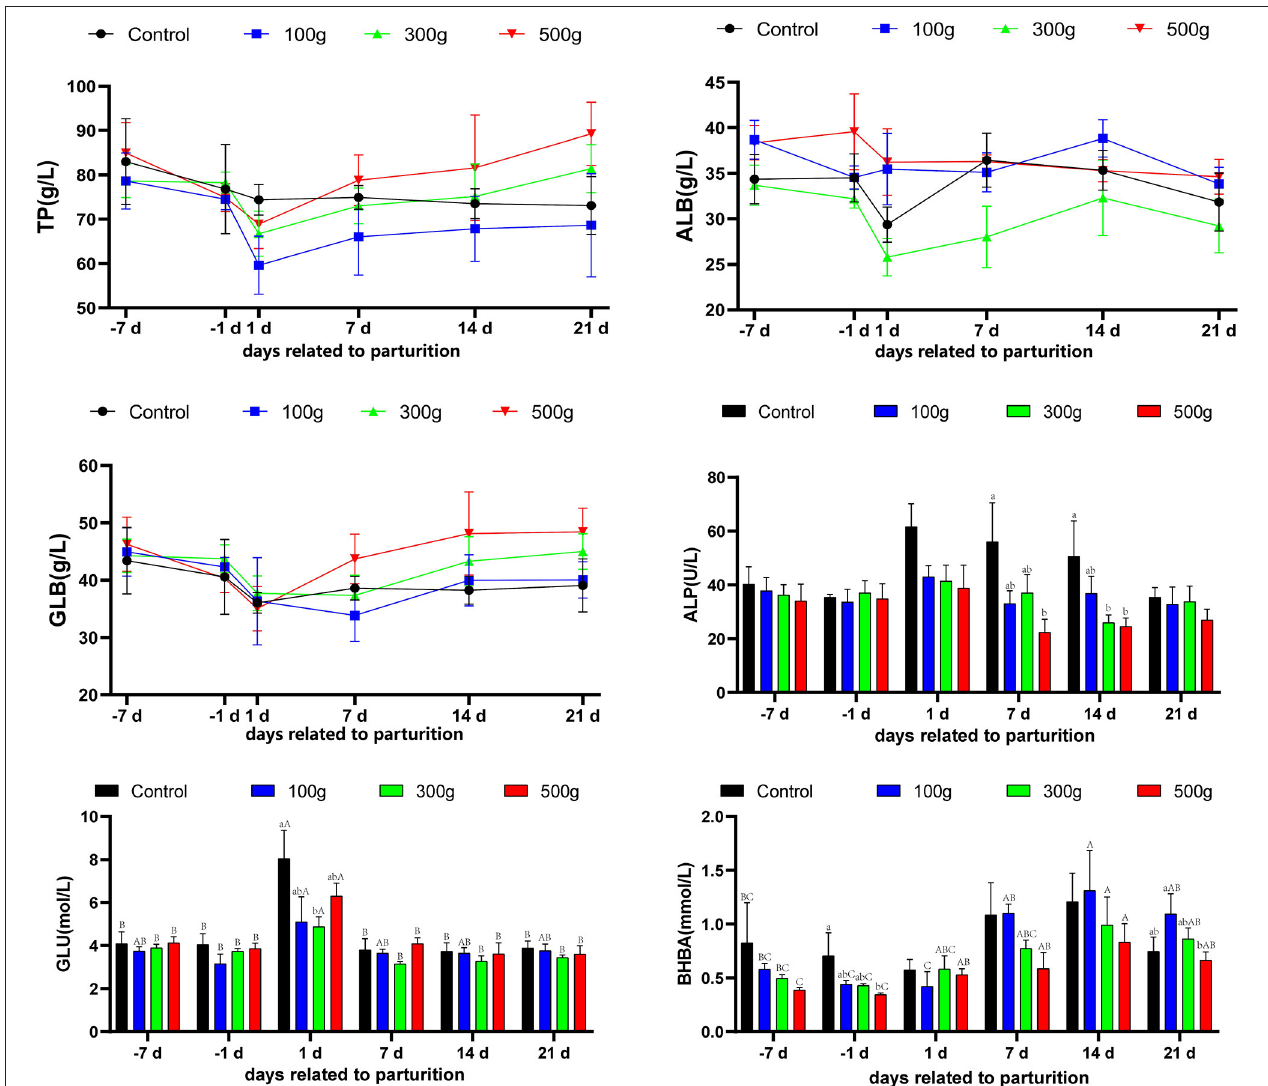
FIGURE 4 | Effects of TCMF4 on serum indexes of cows during the periparturient period. TP, total protein; ALB, albumin; GLB, globulin; ALP, alkaline phosphatase; GLU, glucose; BHBA, β -hydroxybutyric acid. The milk components of the experimental cows were measured on the day of delivery and the 7th, 14th day, and